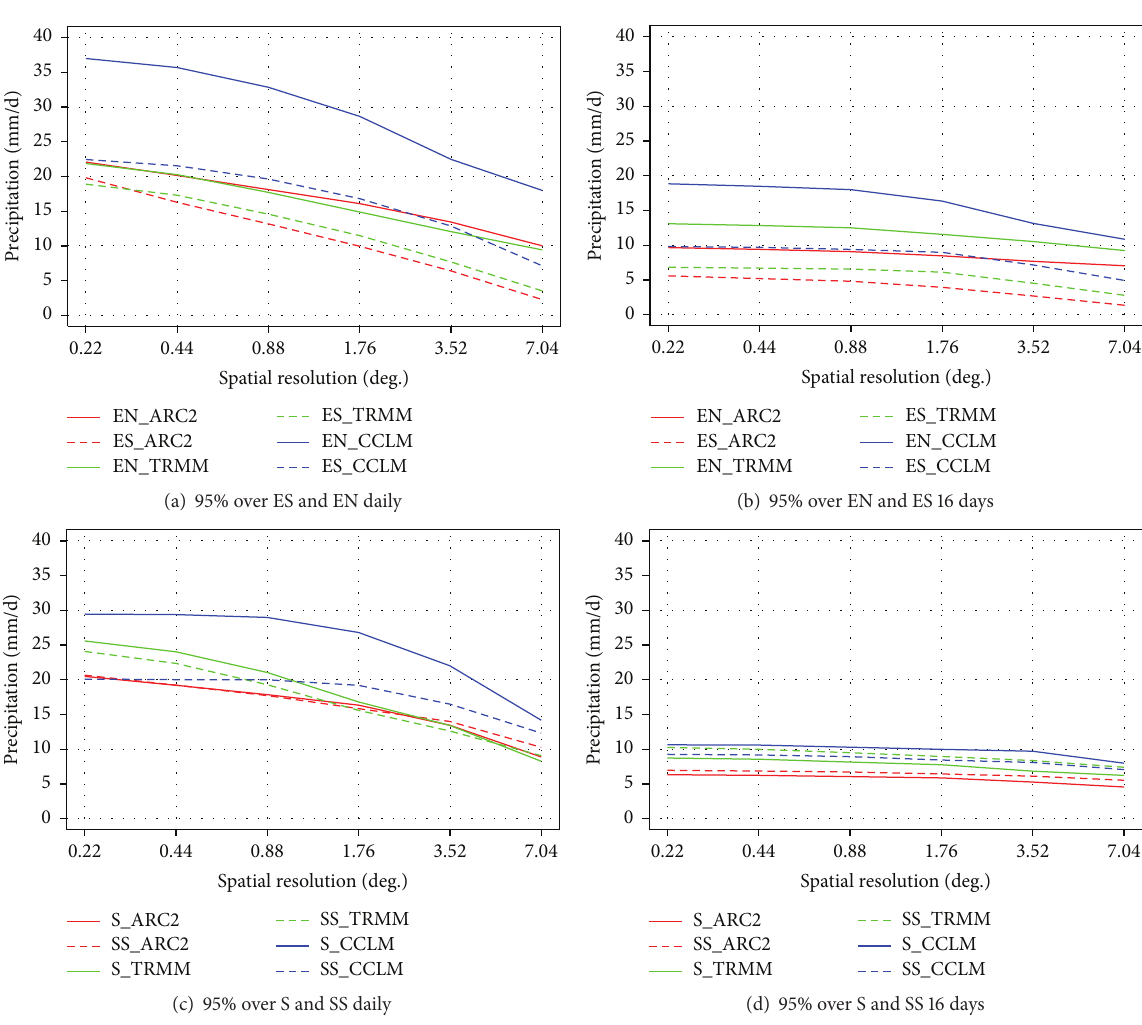
Figure 9: 95th percentile of precipitation (mm/d) for different horizontal resolutions and regions; for COSMO-CLM (blue), TRMM (green), and ARC2 (red) and (a) daily over EN and ES, (b) 16 days over EN and ES, (c) daily over S and SS, and (d) 16 days over S and SS